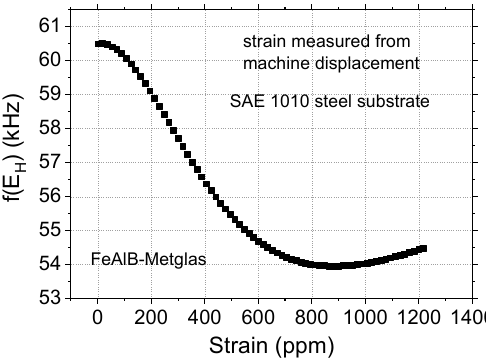
Figure 9. Resonant frequency vs. deformation for sensor with steel substrate.